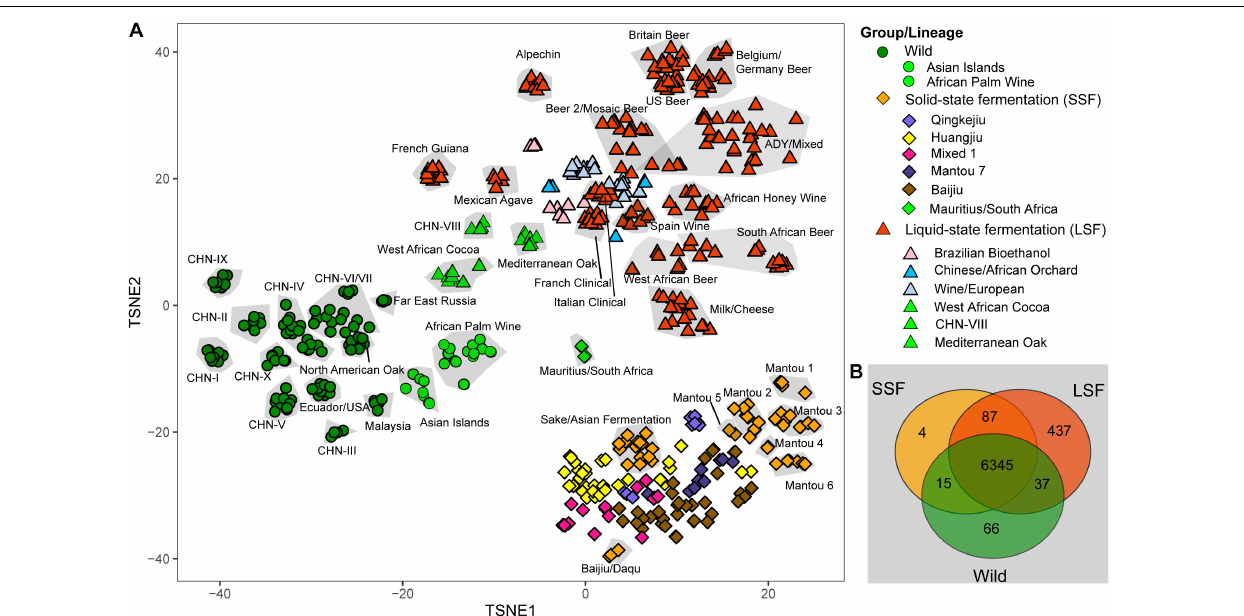
FIGURE 3 | Gene content variations in the genomes of S. cerevisiae isolates. (A) Principal component analysis (PCA) based on the presence or absence of each gene in each isolate. When the isolates belonging to the same lineage form a distinct clustered, they are included in the same gray block. The lineages with isolates that are not clustered together are marked using different colors. (B) Venn diagram based on gene contents. The numbers of genes which are shared by different groups or occur exclusively in single groups are